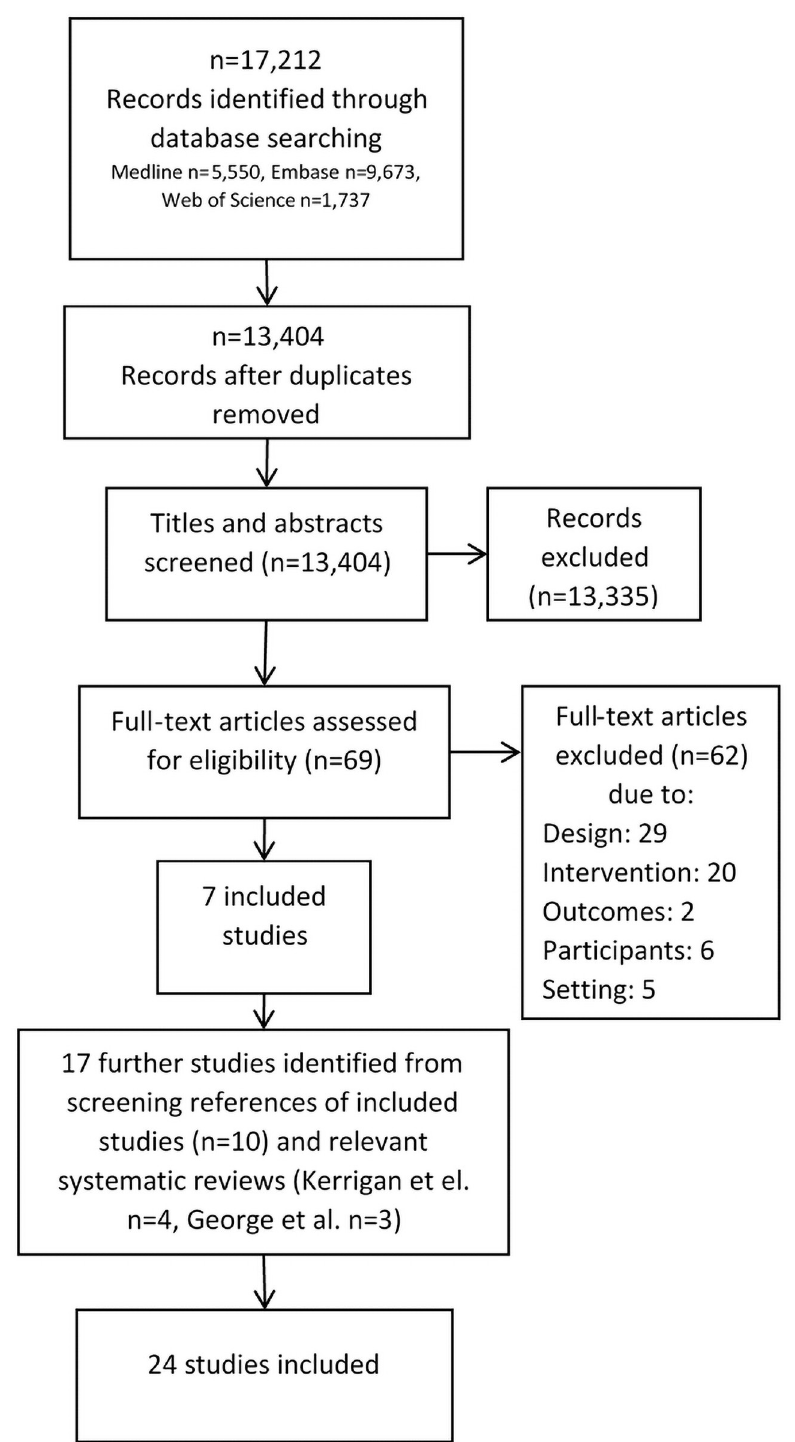
Fig 1. PRISMA flow